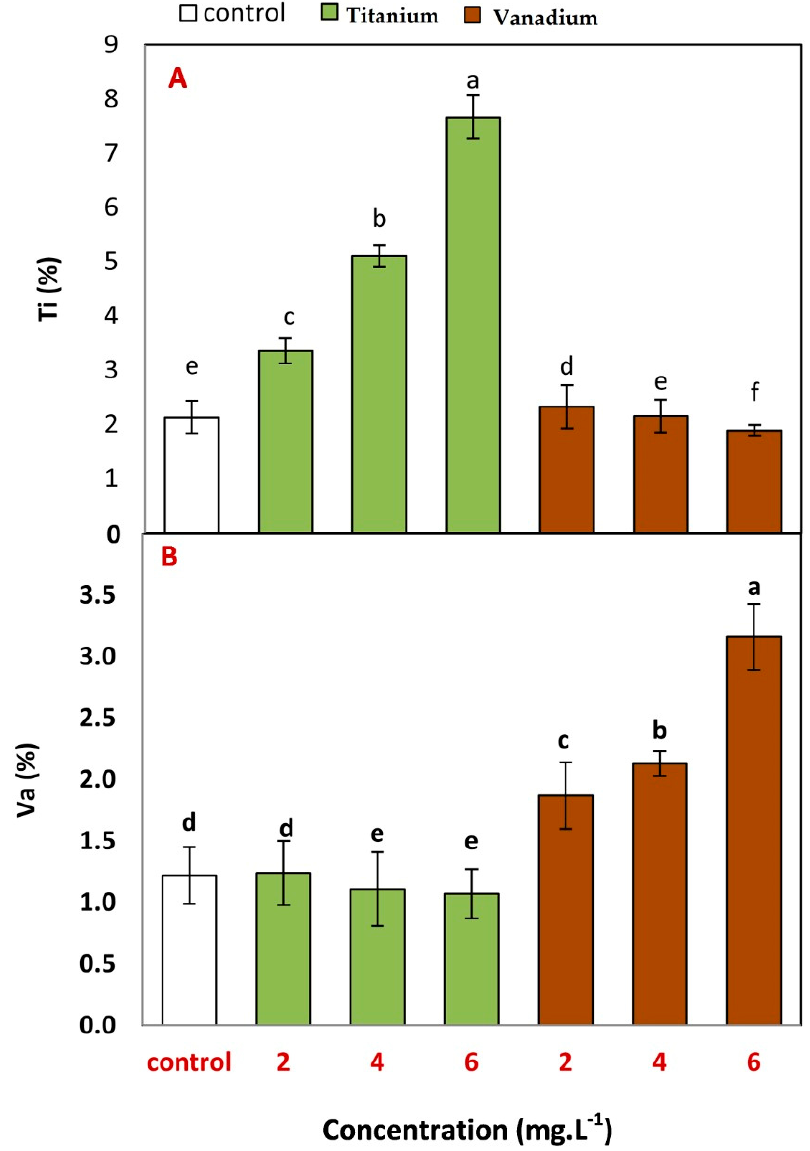
Figure 2. Ti ( A ) and V ( B ) (mg kg − 1 DM) in red cabbage as affected by foliar applications with Ti and V. Data are presented as means of three replicates. Different letters refer to significant difference at p < 0.05 according to the Duncan test ( n = 3).